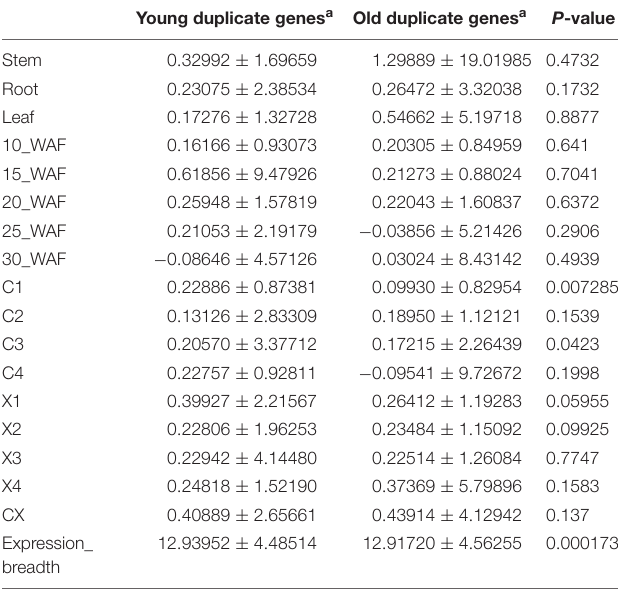
TABLE 1 | Comparison of gene expression levels between old and young duplicate genes in Vernicia fordii